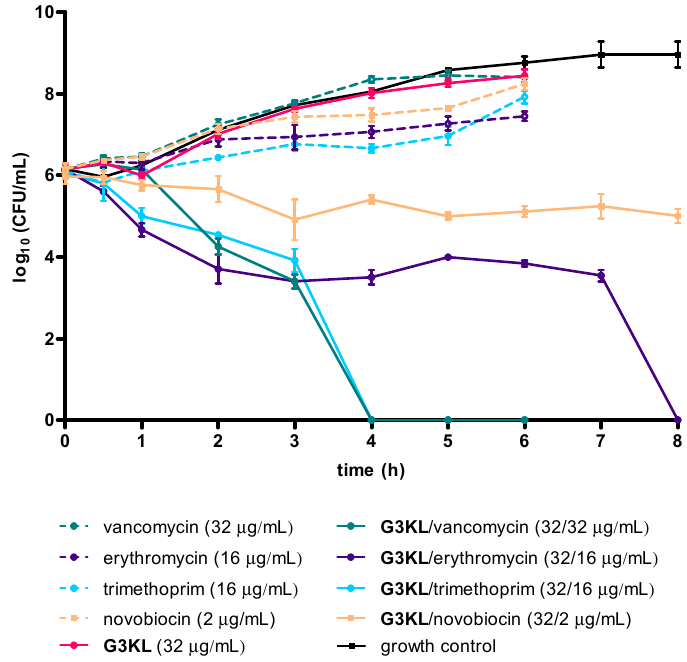
Figure 3. Static time-kill assay with G3KL , the antibiotics vancomycin, erythromycin, and novobiocin, and their combination with G3KL . The experiment showed a decline in K. pneumoniae bacterial burden at 37 ◦ C for the combination of G3KL / vancomycin (32 µ g / mL / 32 µ g / mL), G3KL / erythromycin (32 µ g / mL / 16 µ g / mL), and G3KL / trimethoprim (32 µ g / mL / 16 µ g / mL) below the MIC level. The combination G3KL / novobiocin (32 µ g / mL / 2 µ g / mL) showed inhibition in K. pneumoniae growth. The assays were performed in triplicate.